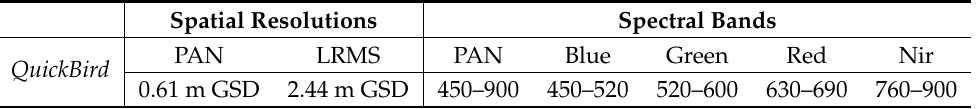
Table 1. Spatial resolutions and spectral bands of QuickBird sensors. The spectral bands report the wavelength ranges (unit: nm). GSD denotes the ground sample